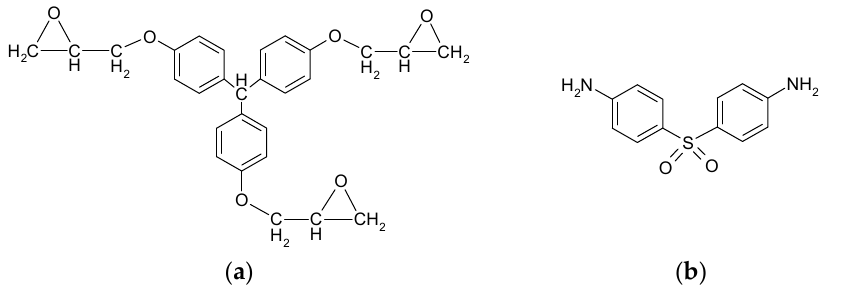
Figure 1 . Chemical structures of ( a ) TETM and ( b ) DDS. Figure 1. Chemical structures of ( a ) TETM and ( b )